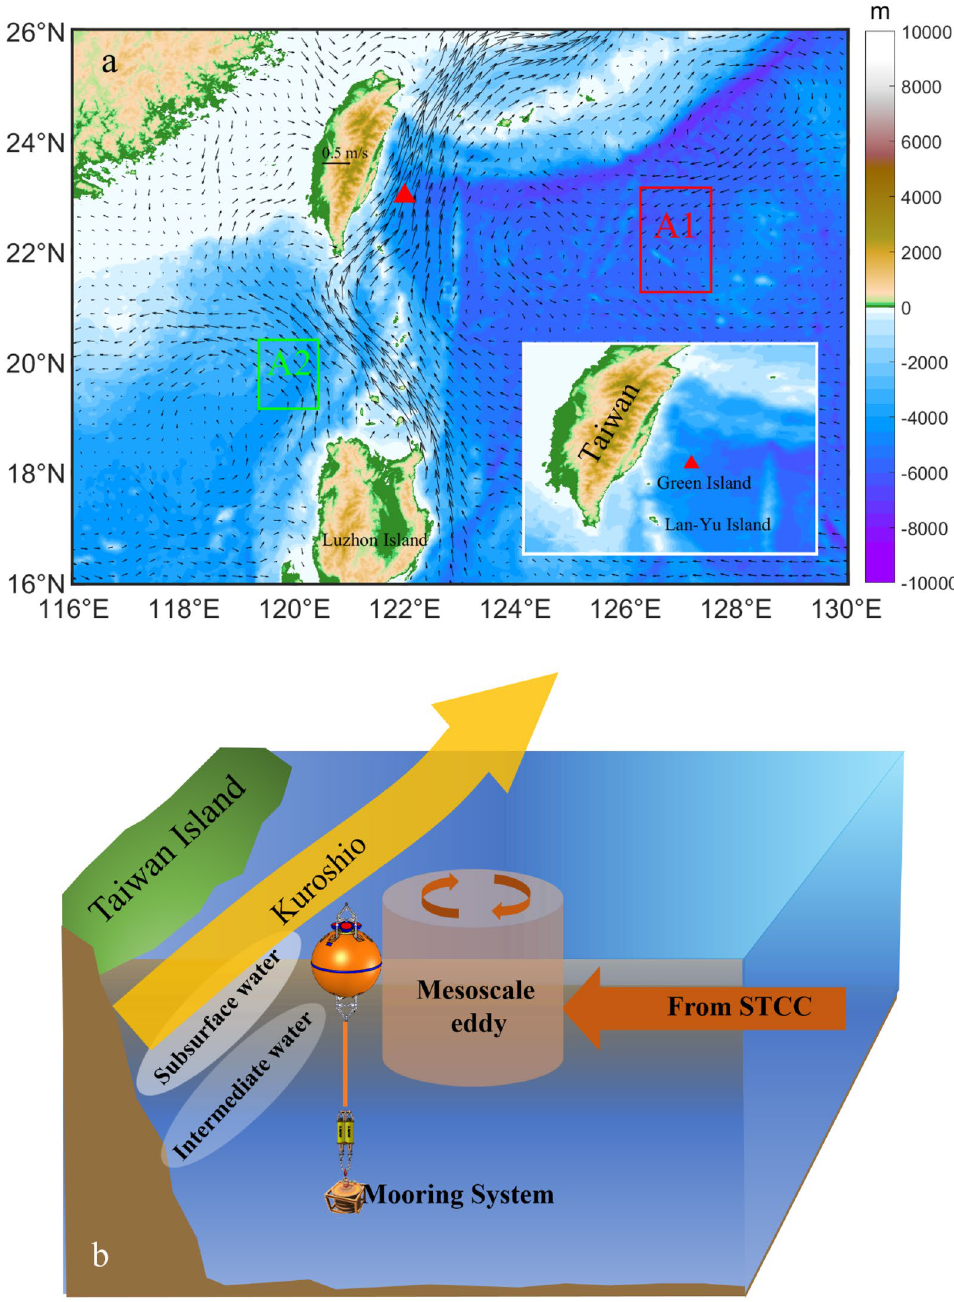
Figure 1. The surface geostrophic currents and a schematic diagram of the water mass distribution around the eastern Taiwan. ( a ) Isobaths (in meters) from data according to the ETOPO1 Global Relief Model (color shading) and average surface geotropic currents between Jan 2016 and May 2017 from AVISO data (vectors). For analysis of properties of IW in this study, the average characteristics of the water masses in two typical regions were selected to represent North Pacific Intermediate Water (in the red A1 box) and South China Sea Intermediate Water (in the green A2 box). The map at the lower right corner of ( a ) shows the zoomed-in topography east of Taiwan. ( b ) Schematic diagram of the water mass distribution and circulation east of Taiwan. The mooring system was deployed from Jan 2016 to May 2017. The topographic data from following website: https:// www. ngdc. noaa. gov/ mgg/ global/ etopo 1sour ces. html. Figures were plotted using MATLAB R2016b (http:// www. mathw orks.